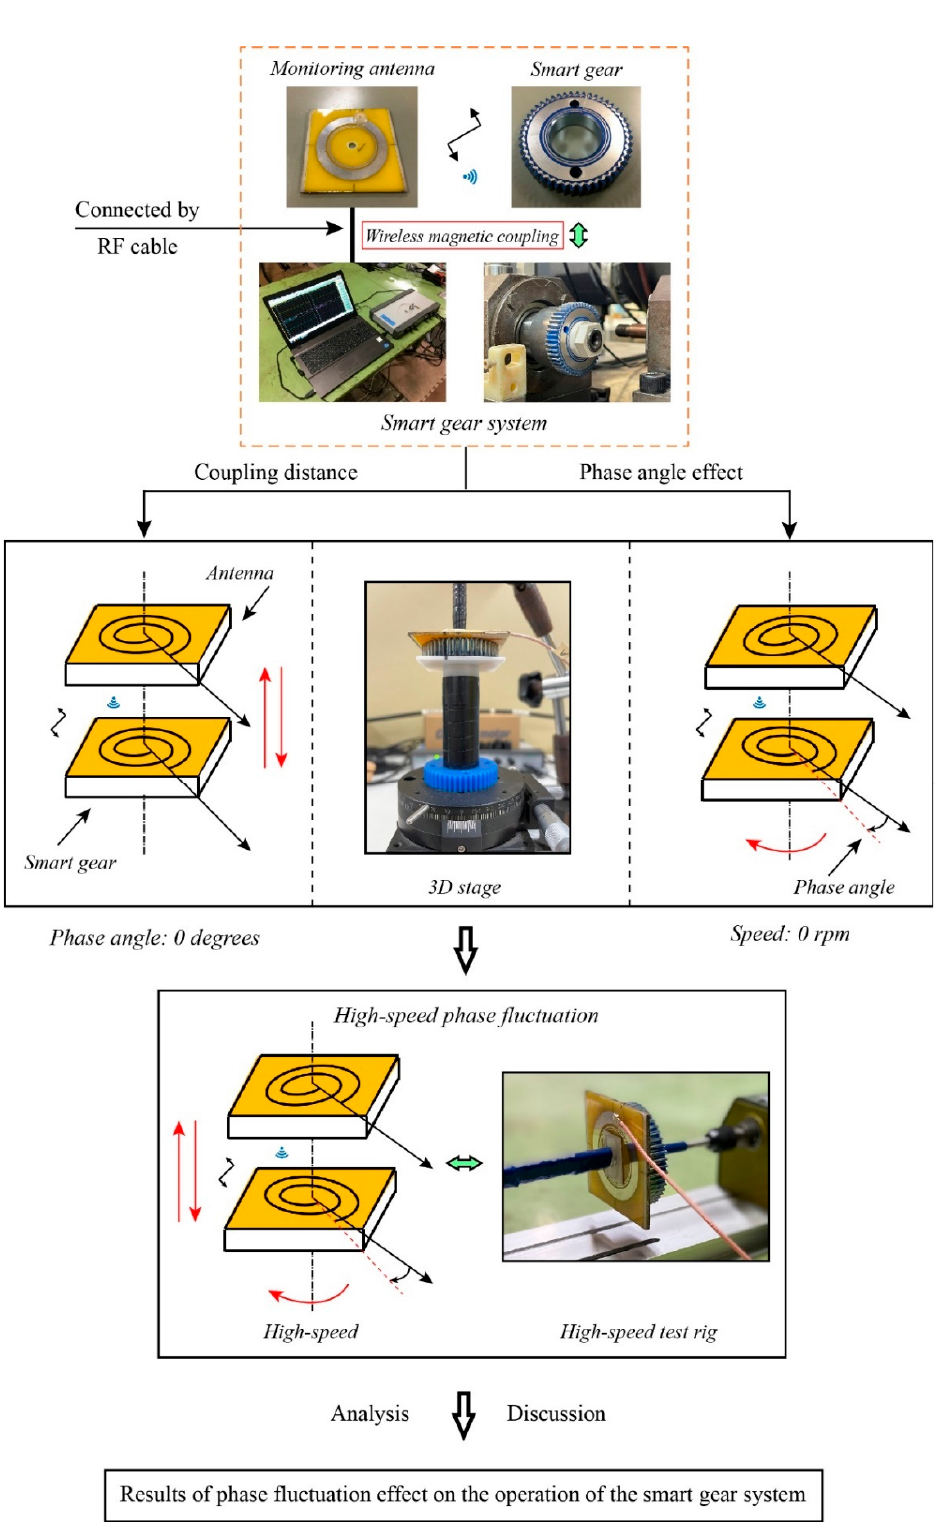
Figure 3. The procedure of the experiments. This figure shows the flowchart of the research. In the second stage, to drive the smart gear at high speed, another test rig has been configured. In this test rig, the monitoring antenna and the smart gear are also aligned concentrically. In contrast to the static phase fluctuation test rig, the smart gear is secured to the spindle of the electrically driven motor in this driving test rig while the monitoring antenna is fixed to a lever that has a grooved rail at its bottom. The grooved sliding rail